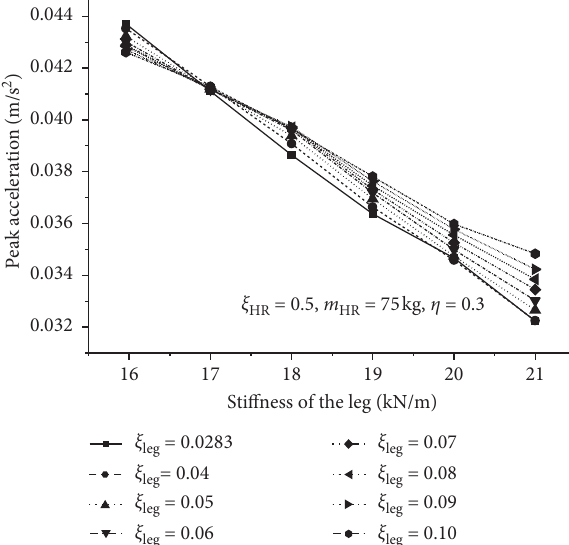
Figure 31: Peak acceleration under ξ � m HR